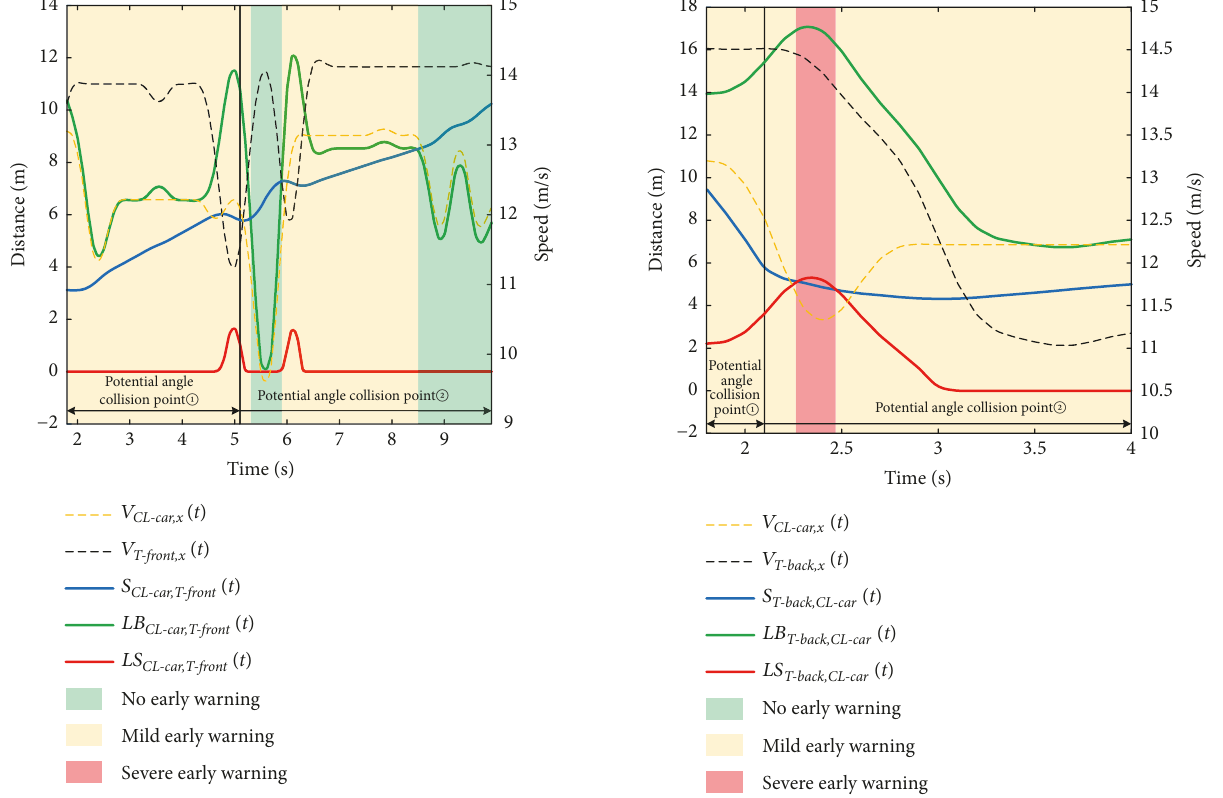
Figure 23: Distance and speed change between CL-car and T-front . Figure 24: Distance and speed change between T-back and CL-car